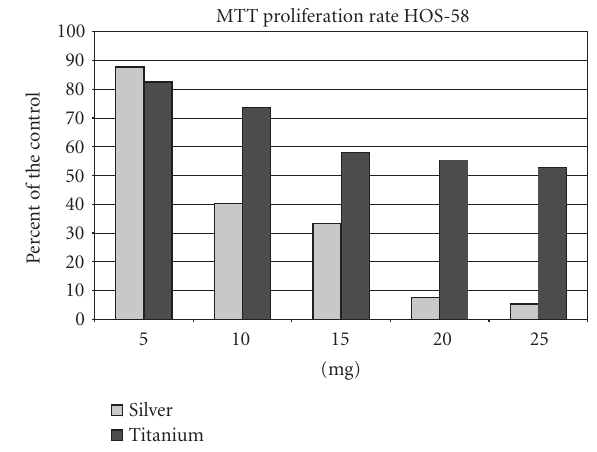
Figure 4: MTT rate of the HOS-58 cell line after supplementation of 5–25 mg silver or